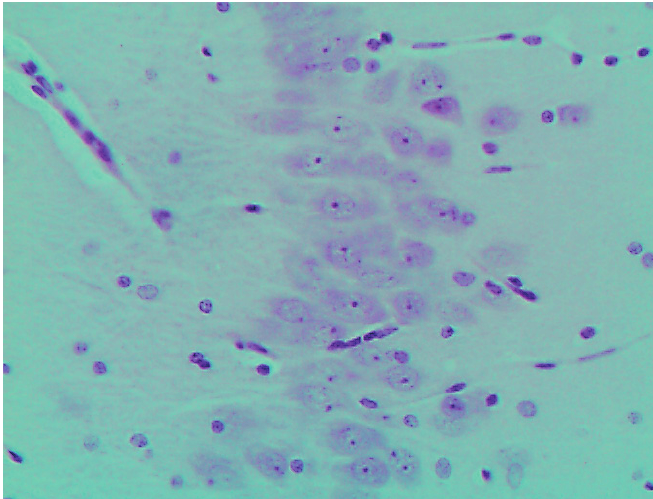
Figure 7. The brain of a rat exposed to nanoparticles of NiO and Mn 3 O 4 together against the background BPC administration; hippocampus (CA1). Hematoxylin and eosin stain,